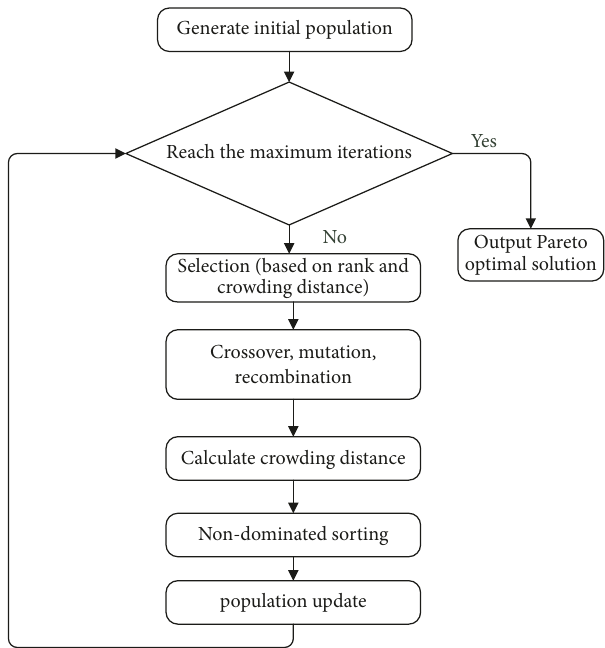
Figure 3: Flowchart of the